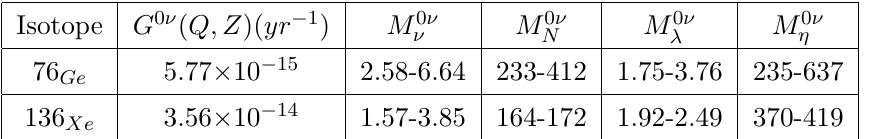
Table 3 . The di(cid:11)erent values of PSF and NME for di(cid:11)erent nuclei used in NDBD experiments. The particle physics parameters governing NDBD for the di(cid:11)erent contributions (ignoring the left triplet Higgs contribution) in LRSM we have considered are given